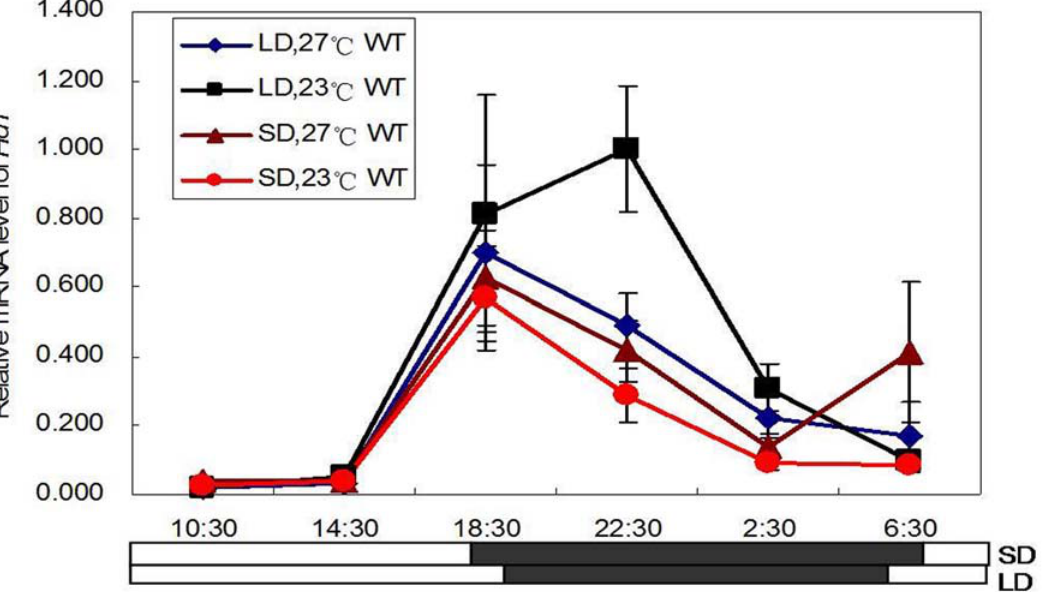
Figure 4. Hd1 expression under different photoperiods and temperatures. Leaves were harvested from 33 day old plants at the indicated times (once every 4 h for 24 h) in phytotrons, and real-time PCR was carried out for analysis of Hd1 . M is lf1132 ; WT is Zhonghua 11.